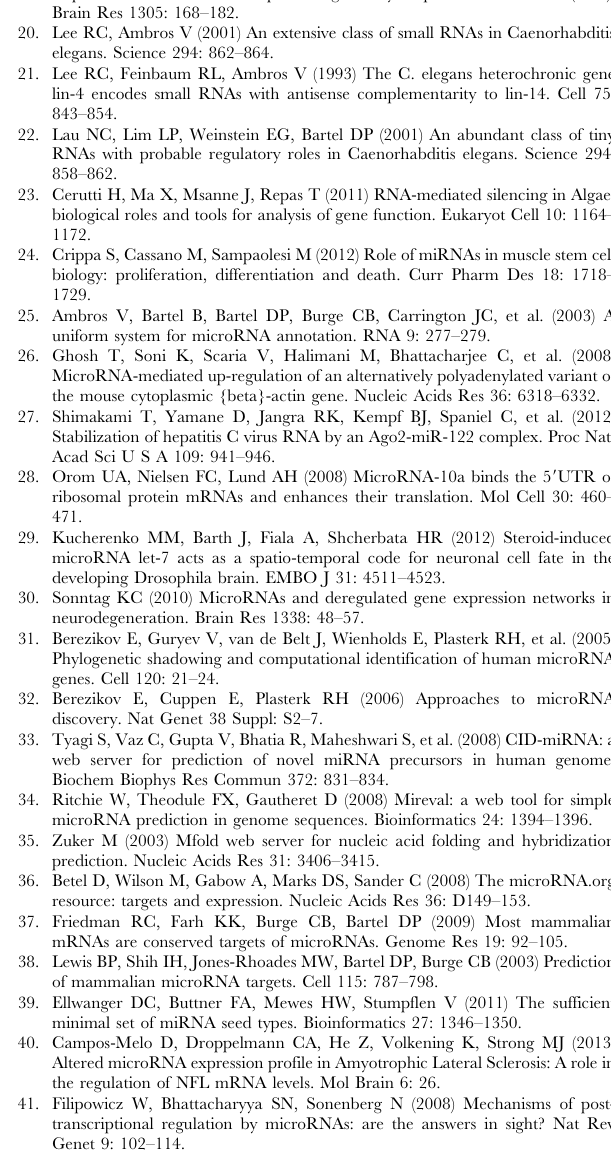
Table S1 Putative novel miRNAs expressed in the human spinal cord. Table S2 Patient demographics of samples used in real- time PCR